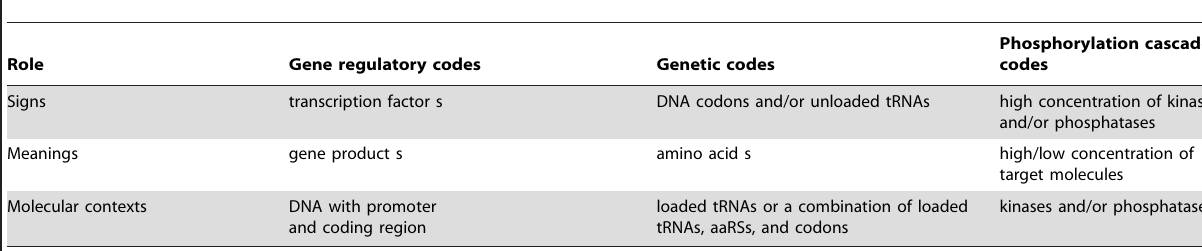
Table 1. Overview of semiotic interpretation of the biological systems surveyed.